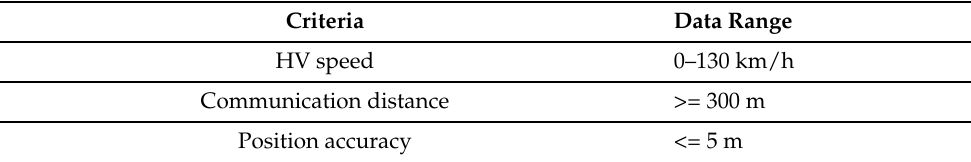
Table 1. Performance criteria of test